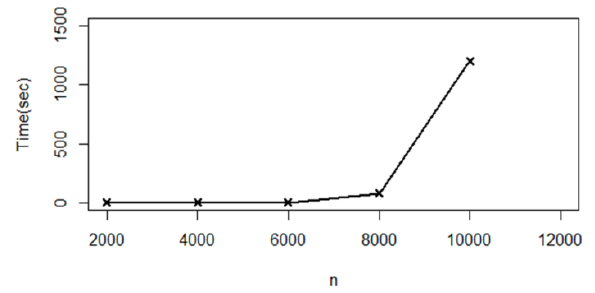
Figure 4. Effect of number of spatial instance